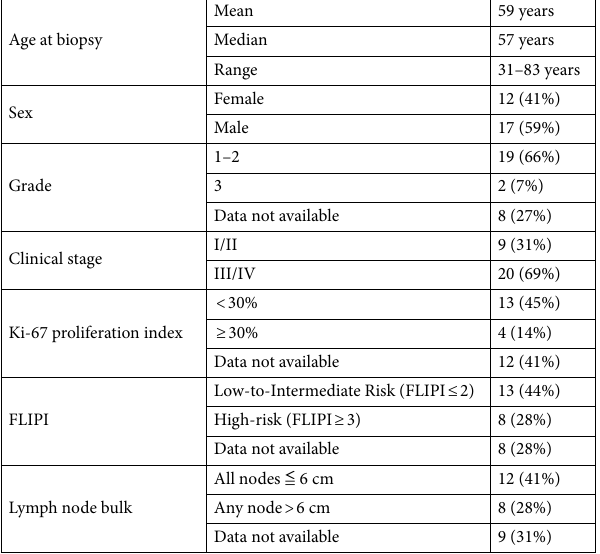
Table 1. FL cases (n = 29): demographic, clinical, pathology and biomarker data.